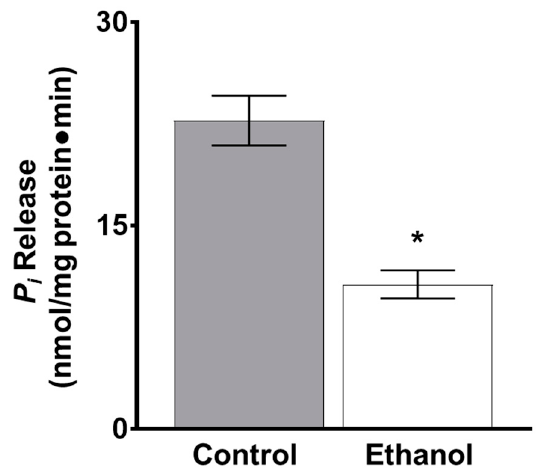
Figure 7. Moderate ethanol inhibited Na-K-ATPase activity in IEC-18 cells. The activity of the Na-K-ATPase was measured as a function of P i release in the presence and absence of moderate ethanol (* p < 0.01, n = 6). The error bars represent the SEM.